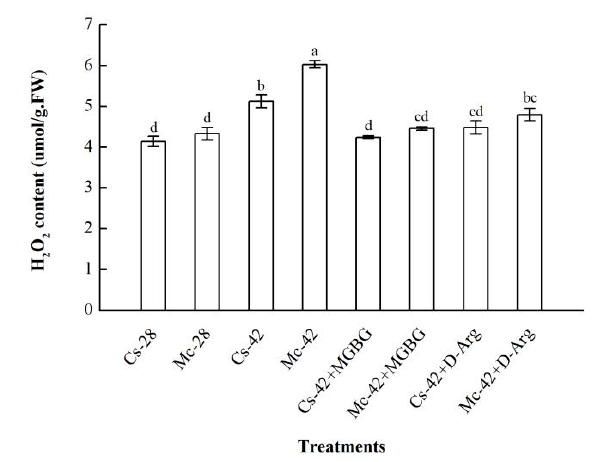
Figure 5. E ff ects of D-arginine (D-Arg) and methylglyoxal bis-guanylhydrazone (MGBG) on H 2 O 2 production in the leaves of self-grafted and bitter-melon-grafted cucumber seedlings under heat stress conditions. Self-grafted plants exposed to 28 ◦ C / 18 ◦ C (day / night), Cs-28; bitter-melon-grafted plants exposed to 28 ◦ C / 18 ◦ C (day / night), Mc-28; self-grafted plants exposed to 42 ◦ C / 32 ◦ C (day / night), Cs-42; bitter-melon-grafted plants exposed to 42 ◦ C / 32 ◦ C (day / night), Mc-42. Seedlings were pretreated with 0.2 mM MGBG and 2mM D-Arg for 12 h, respectively, after which they were treated under high temperature conditions for 8 h. Bars represent the mean ± SE of at least three independent experiments. The di ff erent letters indicate significant di ff erences at p < 0.05 according to Duncan’s multiple range